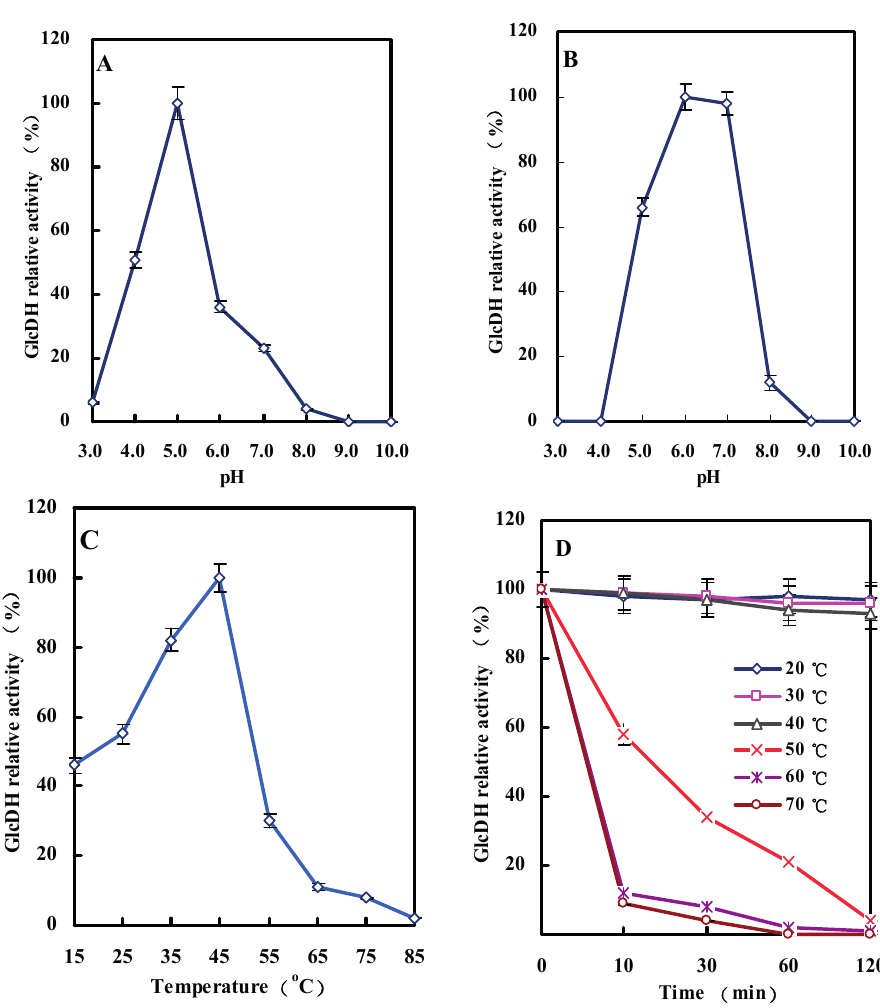
Figure 6. Effects of pH and temperature on the GlcDH activity from A. globiformis C224. ( A ) Optimum pH of GlcDH; ( B ) pH stability of GlcDH; ( C ) Optimum temperature of GlcDH; ( D ) Temperature stability of